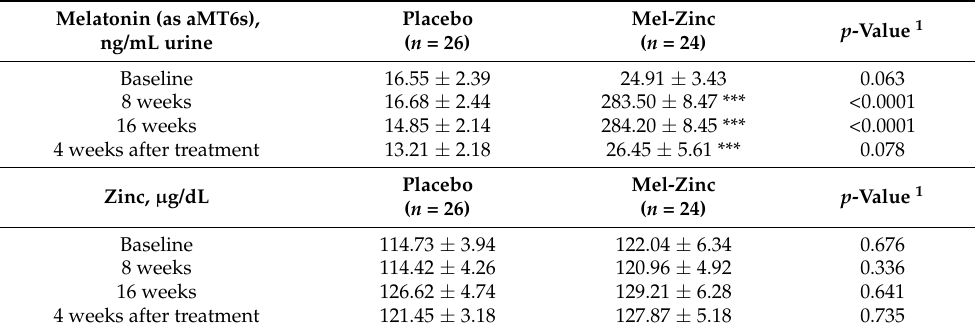
Table 5. Levels of 6-sulphatoxymelatonin and zinc of the study participants who completed the final